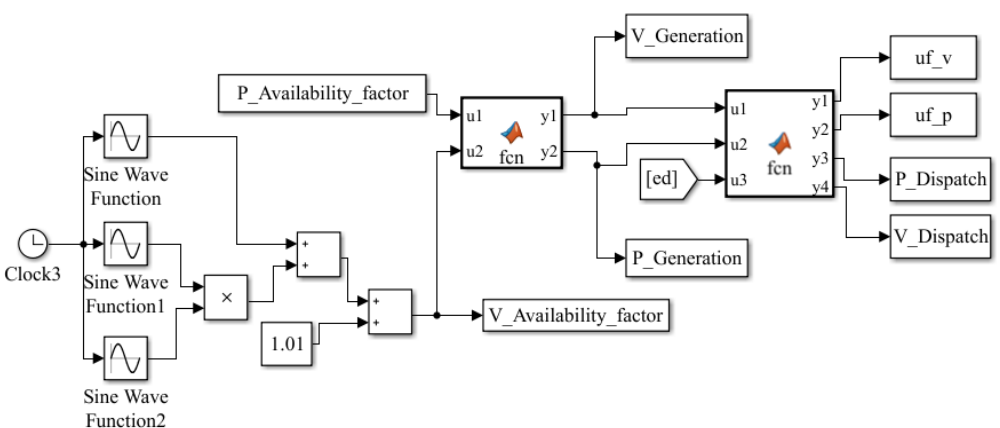
Figure A3. Electricity